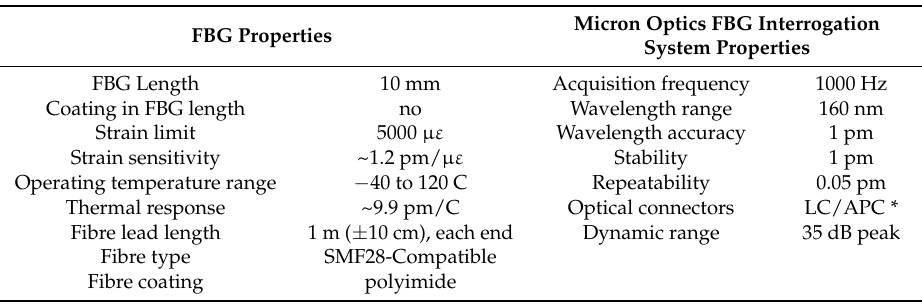
Table 1. FBG and interrogation system properties.